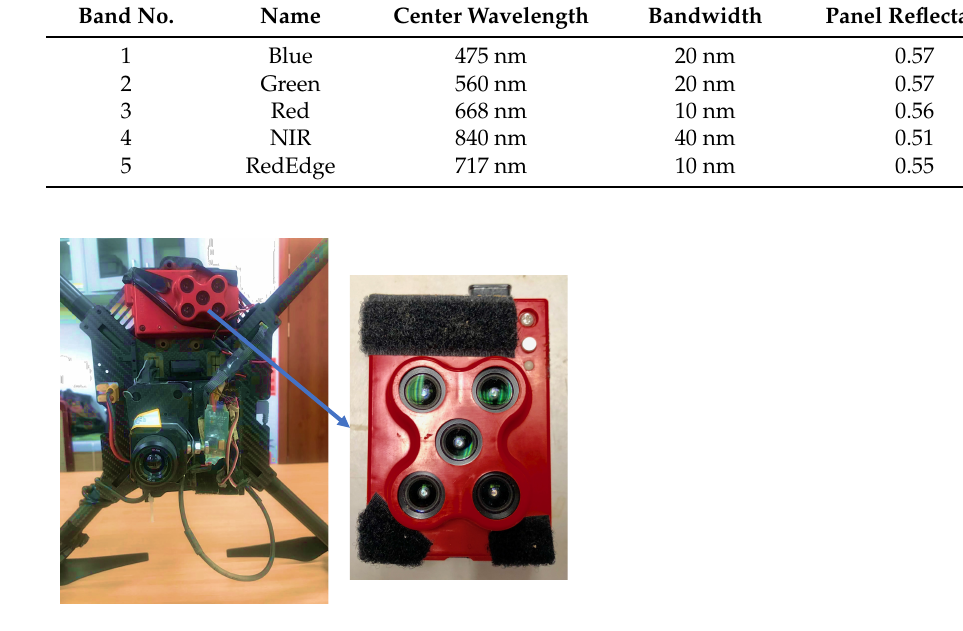
Figure 3. M100 UAV with the RedEdge camera.